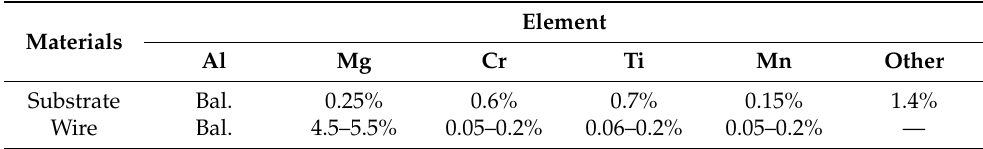
Table 1. The content of each element in the substrate and